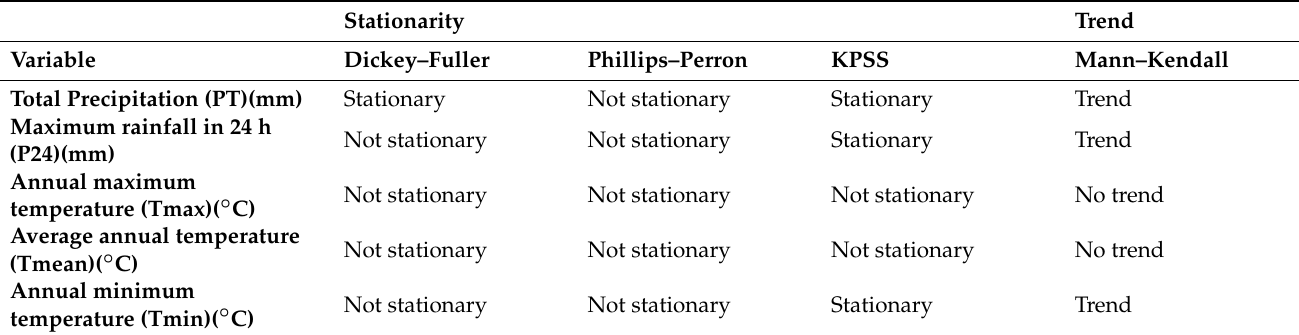
Table 3. Results of the stationarity and trend tests for the PT, P24, Tmax, Tmean and Tmin